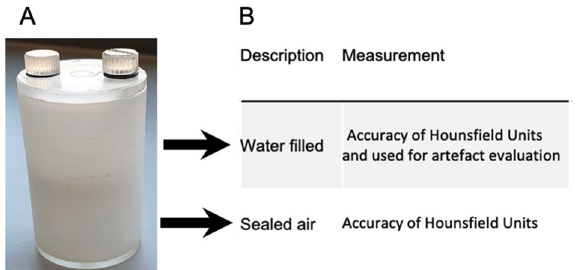
Fig. 8 Two-chambered CT image quality control phantom (QC) (6.5 displays an image of the QC phantom. Panel B outlines the individual chambers/sections of the phantom as